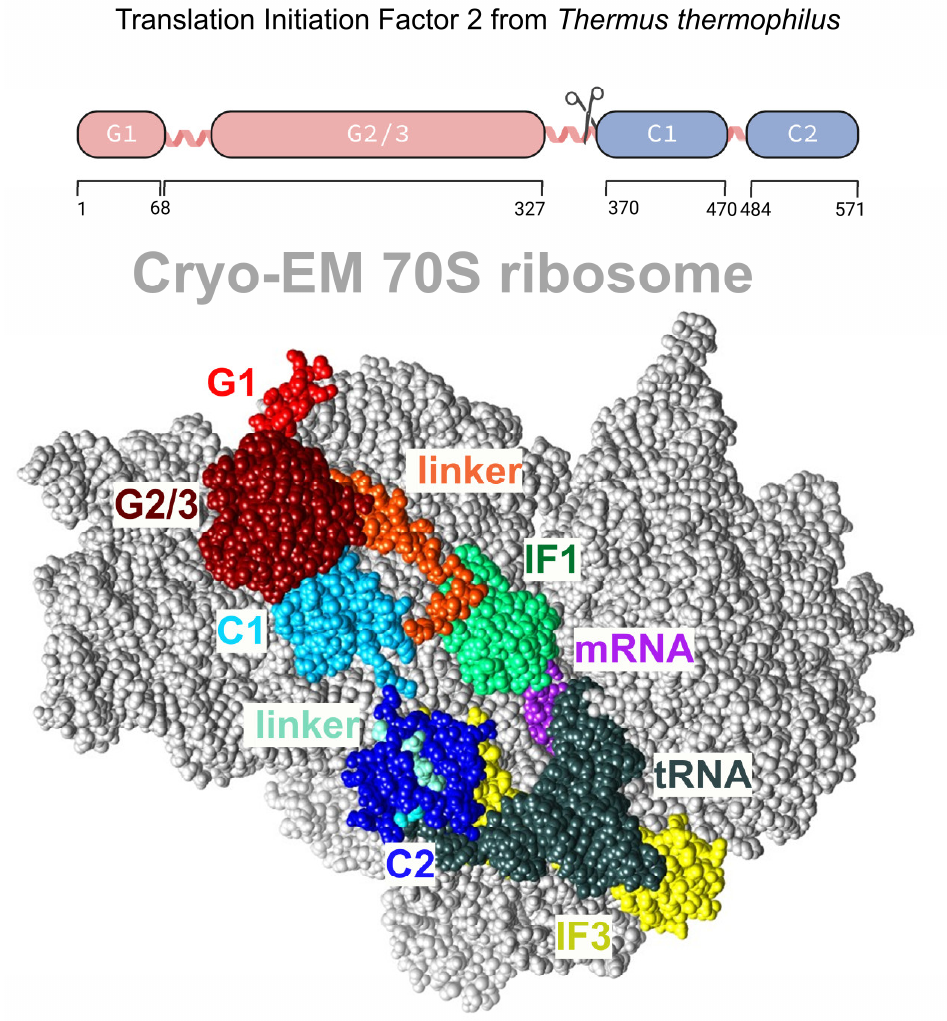
Figure 1. The division (upper part) of translation initiation factor 2 from Thermus thermophilus into the G fragment (red), consisting of G1 and G2/3 domains, and the C fragment (blue) consisting of C1 and C2; cryo-EM model (lower part) of ribosome-bound IF2 prepared based on the structure in PDB [5LMV], with binding partners (IF1, tRNA, mRNA, and IF3) shown as colored molecular surfaces. The X-ray crystal structures of full-length Thermus thermophilus apo IF2 and its complex with GDP have been obtained at 3.1 Å resolution [20,27]. The structure of IF2 bears a resemblance to beads on a string, rather than exhibiting a chalice shape similar to eIF5B. IF2 adopts a stable and ordered conformation when interacting with the ribosome, which is facilitated by the predetermined inherent flexibility and expandability of the protein (Figure 1). Possible elements of flexibility are long helices. The overall dimensions of IF2 depend on the nucleotide status of IF2. The apoform of T. thermophilus IF2 is more extended, while the GDP-bound IF2 appears more compact. However, IF2 is significantly larger when in a functionally active state, bound to the 30S ribosomal subunit. Unlike all other translational GTPases, IF2 does not have an effecter domain that stably